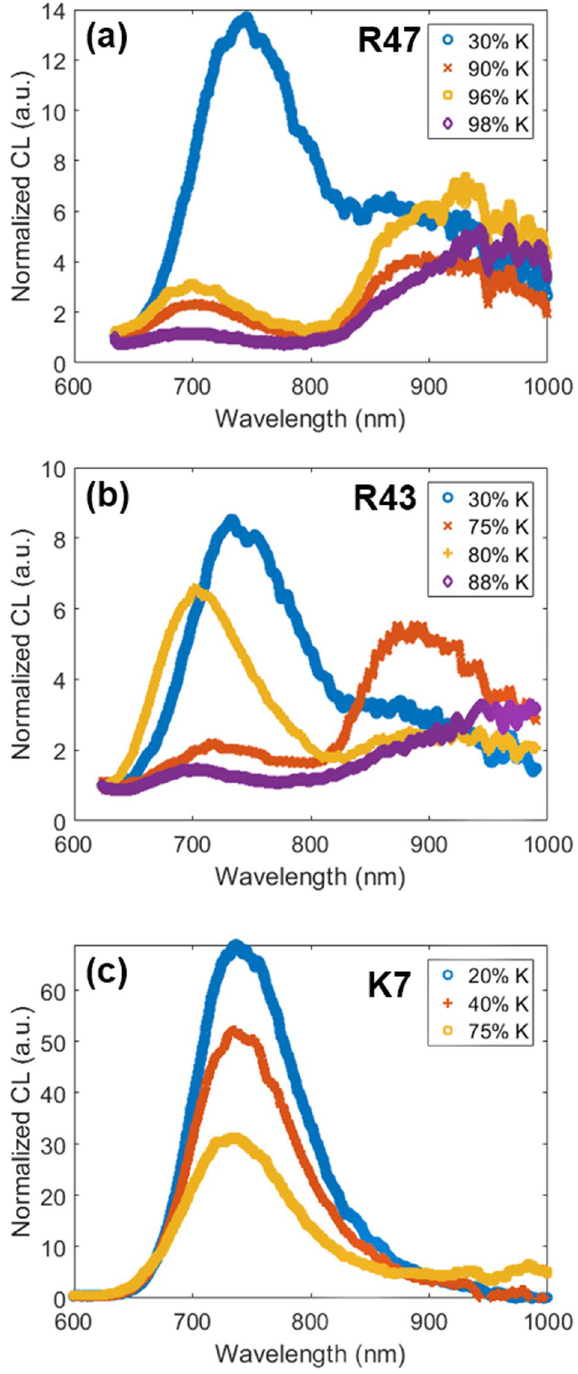
Figure 5. Local CL spectra of samples ( a ) R47, ( b ) R43, and ( c ) K7, obtained from low (20–30%), moderate and high K-rich regions (40%-98%). Savitzky-Golay filter was applied to smoothen the spectra. These images were generated using Matlab (Version: R2016, Url: https ://www.mathw orks.com/produ cts/matla